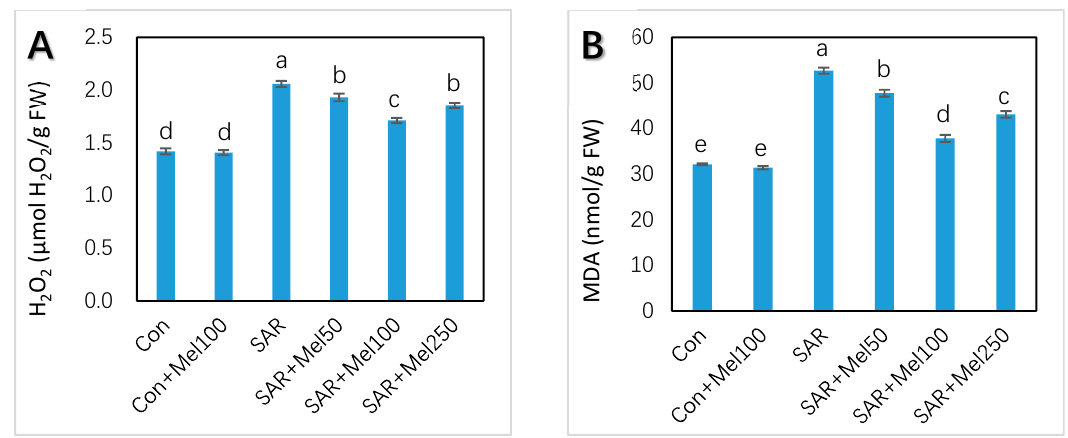
Figure 5. Accumulation of ( A ) H 2 O 2 and ( B ) MDA concentration in tomato leaves by SAR and/or melatonin treatments. Data indicate here the mean of four replications. Vertical bars indicate the standard error. Means not sharing a common letter within the graph are significantly different at p ≤ 0.05 according to Tukey’s test.